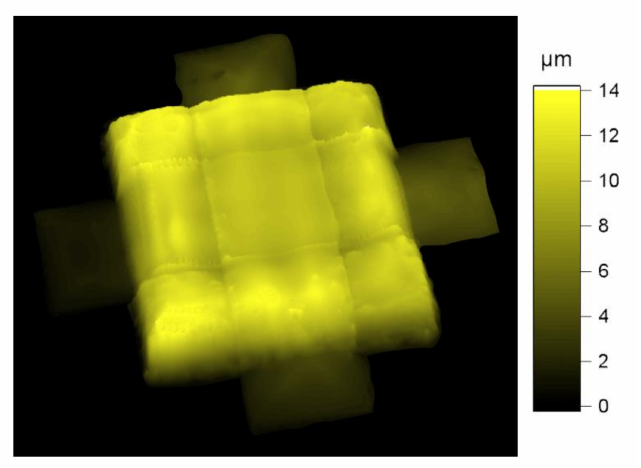
Figure 3. 3D-topography of a printed multilayer capacitor, with three parallel-connected dielectric layers (each printed with a drop spacing of p = 90 µ m), printed as shown in Figure 1. To investigate the dielectric behavior of the multilayer capacitors, two di ff erent combinations of drop spacing for the dielectric layers were used, with p = 70-70-70 and 70-80-80 µ m. The layer thicknesses were determined via SEM images, and the capacitances as well as the loss factors were measured via impedance spectroscopy at a frequency of 200 kHz. As additional supporting structures are printed, the same drop spacing can lead to thicker layers for the second and the third composite layer. In order to examine the dielectric properties of the multilayer capacitors successively, the capacitance and the loss factor were measured after each completed dielectric layer, which was equipped with an ◦ electrode. After every printed layer, the structures were dried at 90 C in a vacuum furnace for 20 h so that the conductivity of the silver electrodes was high enough (resistivity < 10 Ω ). First, the capacitors with a drop spacing of each 70 µ m were studied, for which the dielectric properties for every additional layer are shown in Table